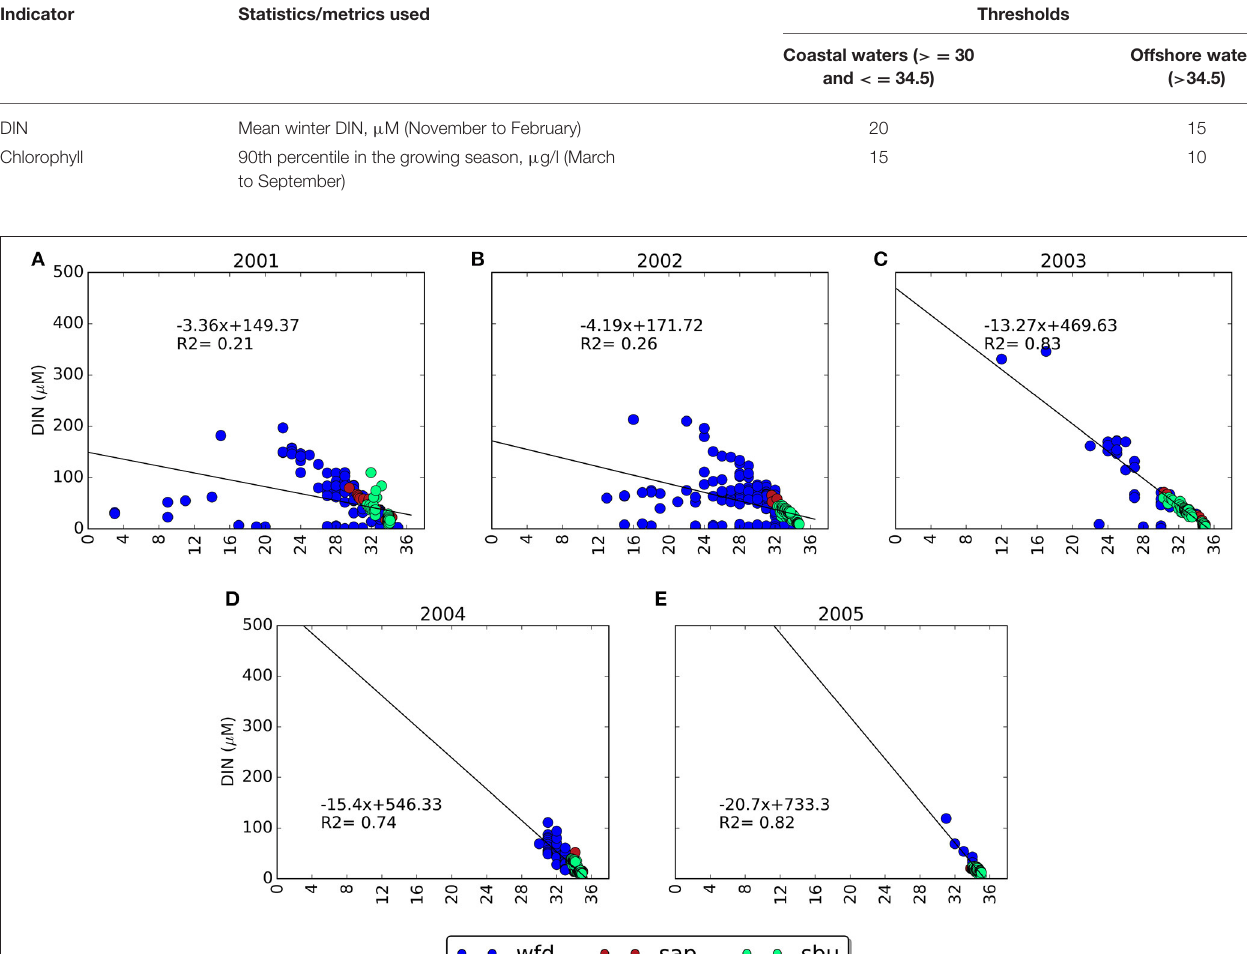
TABLE 1 | Statistics applied to DIN and Chlorophyll and assessment thresholds. Indicator